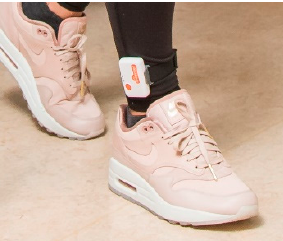
Figure 2. Placement of the Inertial Measurement Unit (IMU) on the lateral side of the ankle, above the malleoli.